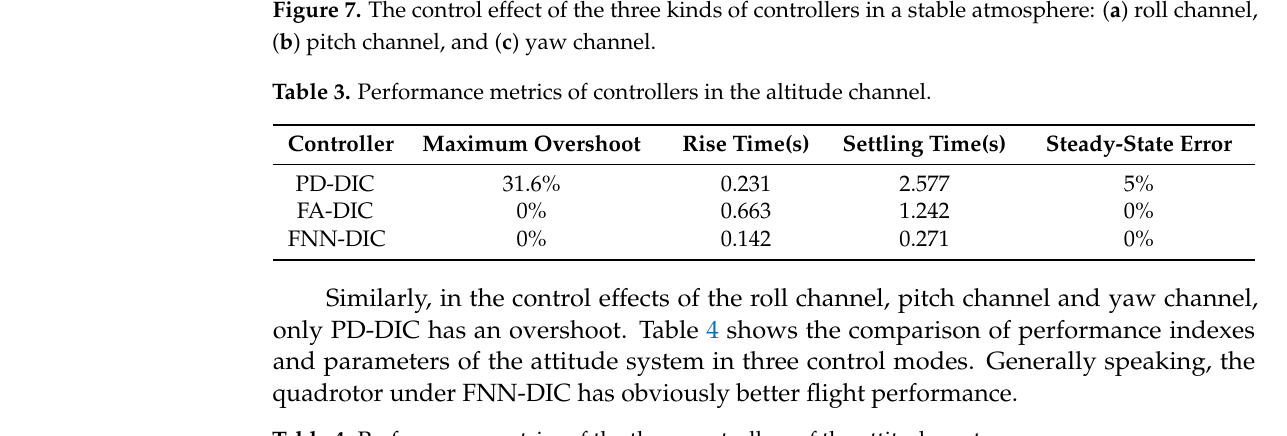
Table 3. Performance metrics of controllers in the altitude channel. Table 4. Performance metrics of the three controllers of the attitude